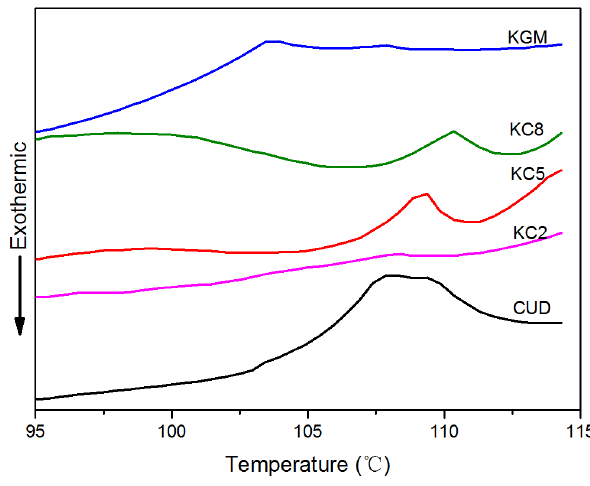
Figure 9. DSC profiles of KGM/CUD blend hydrogels at 95–115 °C.